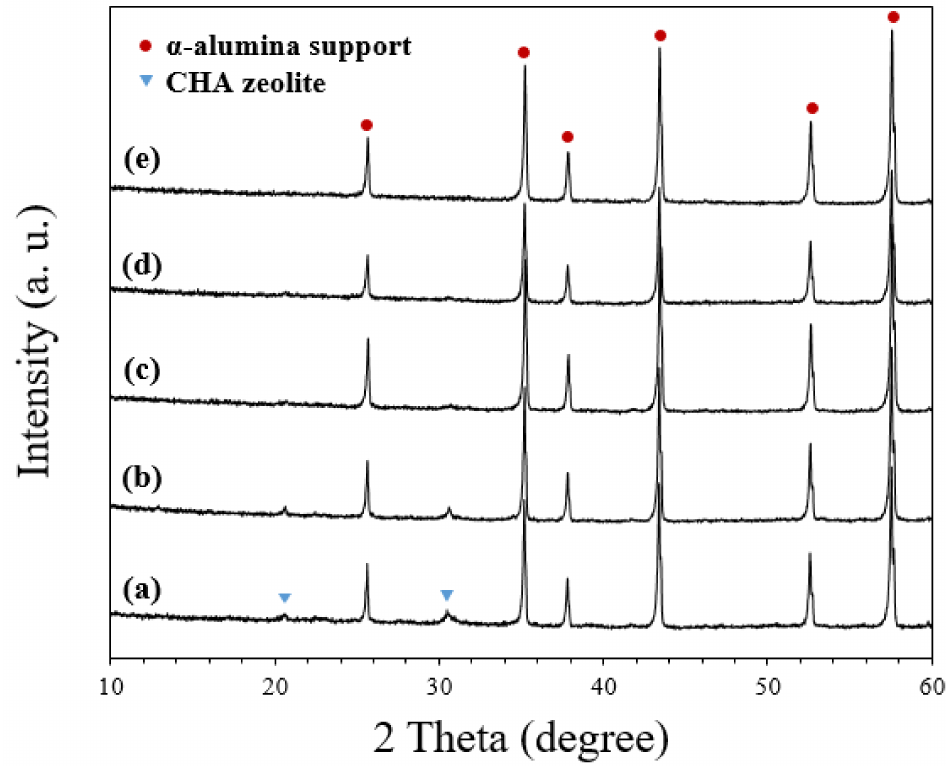
Figure 5. X-ray diffraction patterns of synthesized CHA zeolite membranes using planetary-milled ( a ) S1, ( b ) S2, ( c ) S3, ( d ) S4, and ( e ) S5 seed